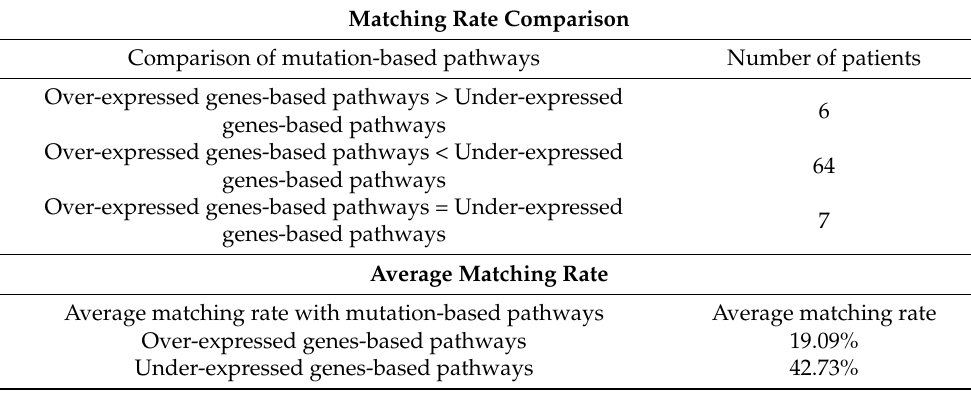
Table 3. Overlapping of mutation-based pathway and mRNA over- or under-expressed genes-based pathways, and their matching rate comparison.